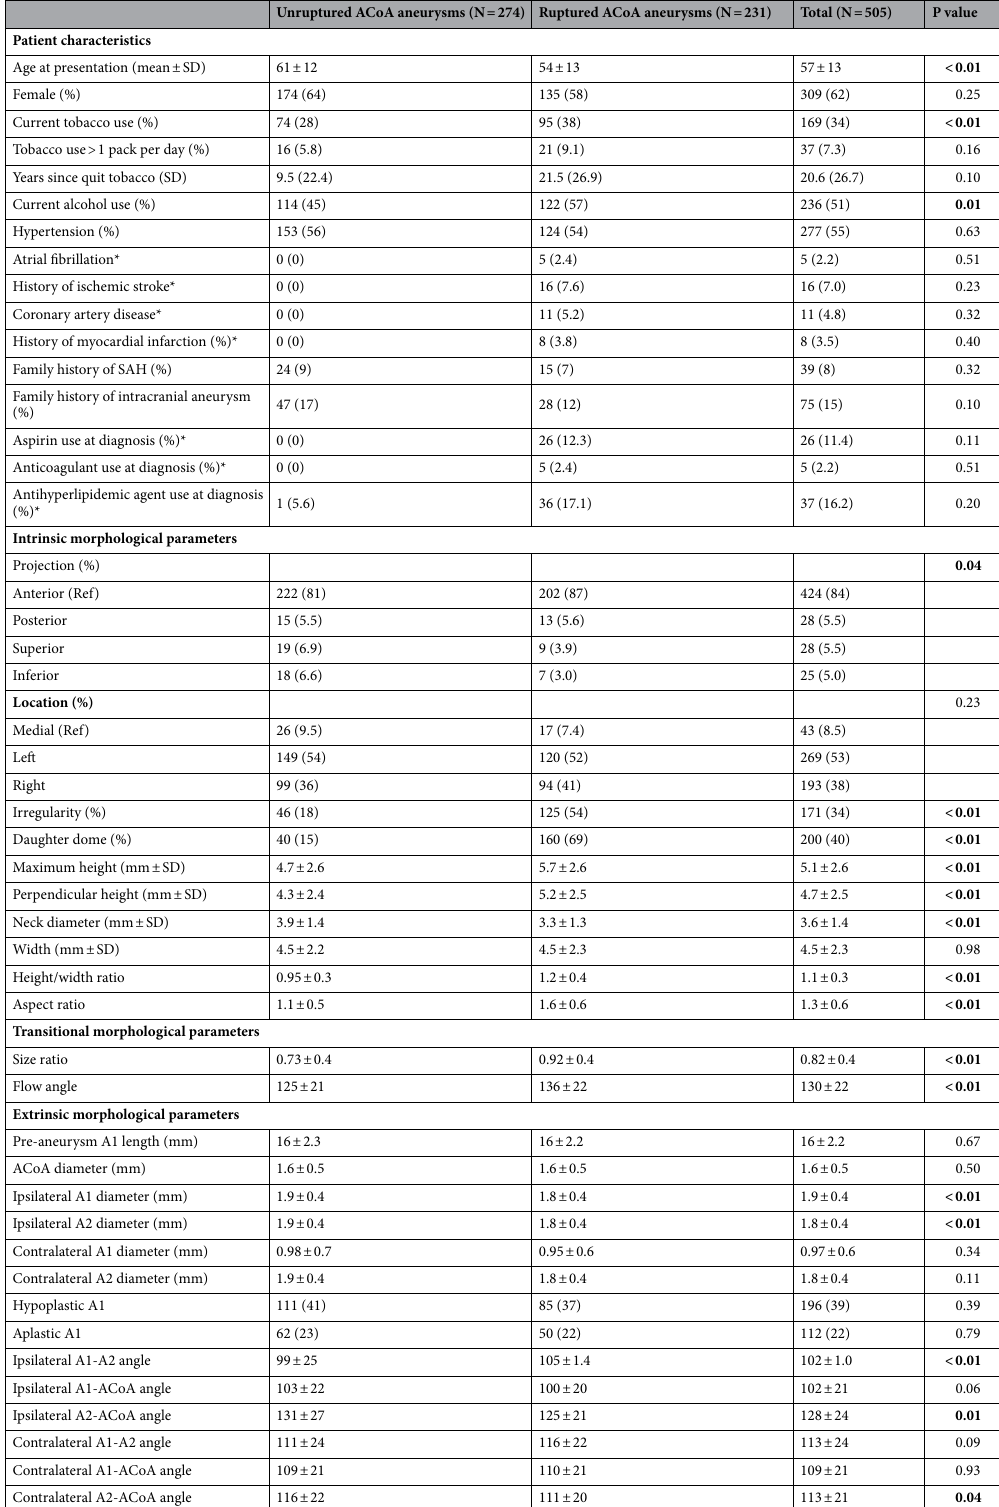
Table 1. Baseline demographics and aneurysm characteristics of patients with unruptured and ruptured anterior communicating (ACoA) aneurysms (N = 505). ACoA anterior communicating artery, Ref reference, SAH subarachnoid hemorrhage, SD standard deviation. *Available data in 229 patients. Percentages calculated based on available